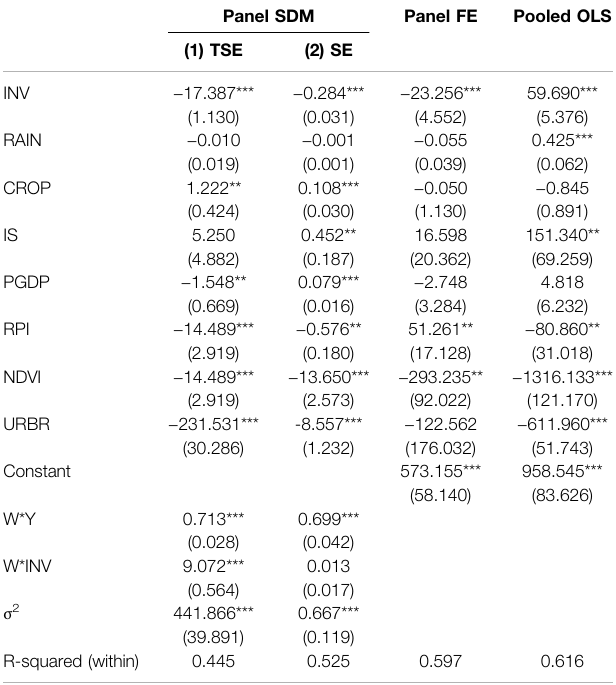
TABLE 5 | Estimation results of the model speci fi ed in Eq. 11 with different speci fi cations: panel SDM, panel FE, and pooled OLS. Panel SDM